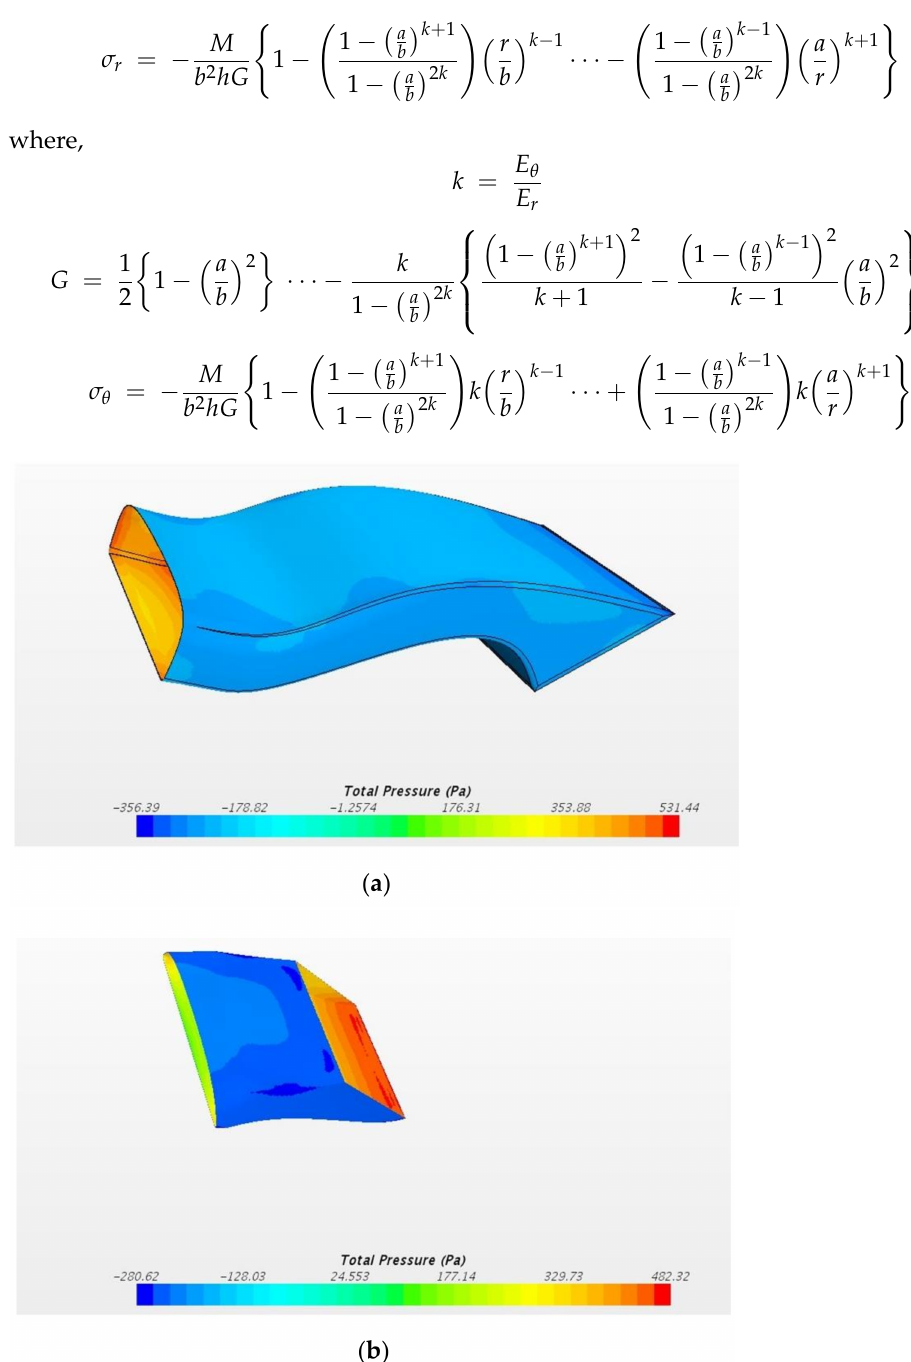
Figure 5. Pressure distribution by CFD analysis. ( a ) Pressure distribution of intercooler; ( b ) pressure distribution of